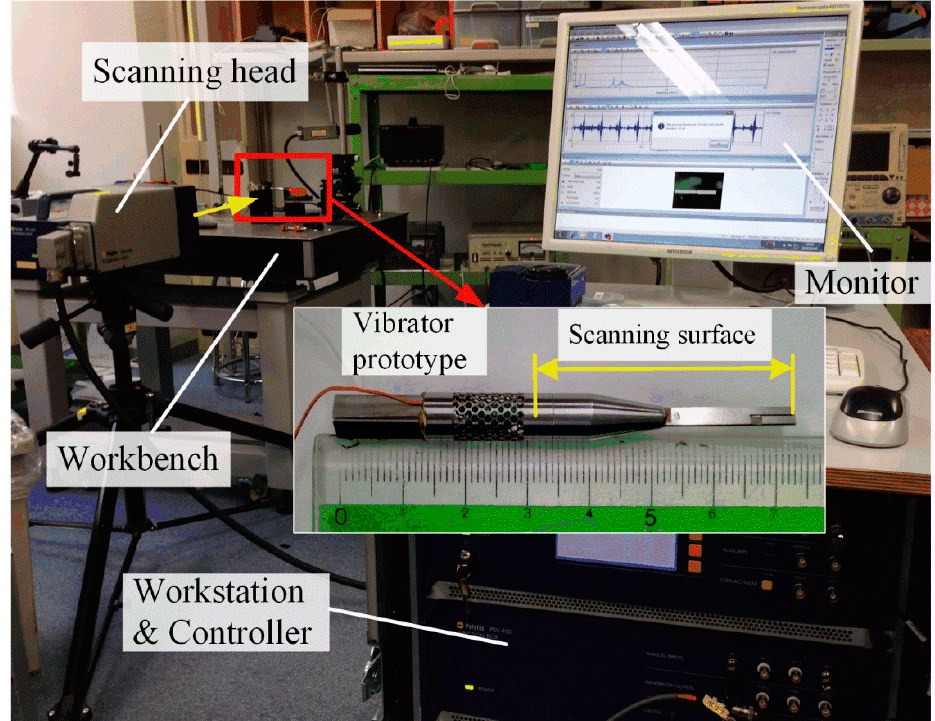
Figure 9. The experiment setup for vibration mode detection.